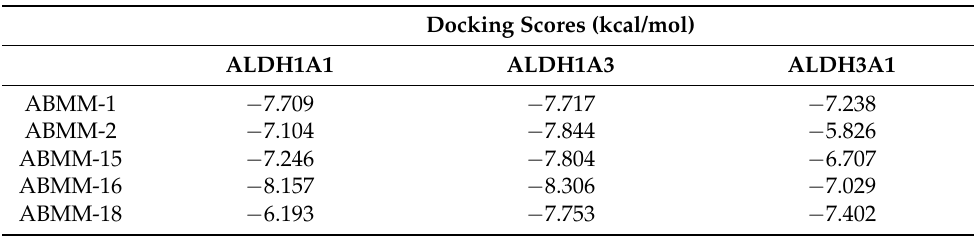
Table 4. Docking scores (kcal/mol) for compounds ABMM-1, 2, 15, 16 and 18, against the three ALDH isoforms (ALDH1A1, 1A3 and